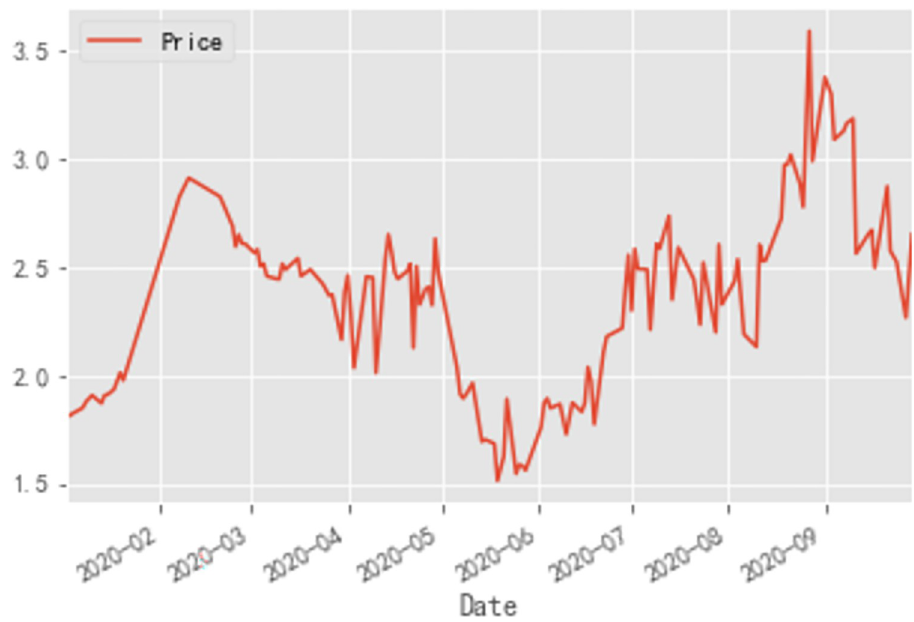
Fig 12. Time series of cabbage prices from January to September 2020.